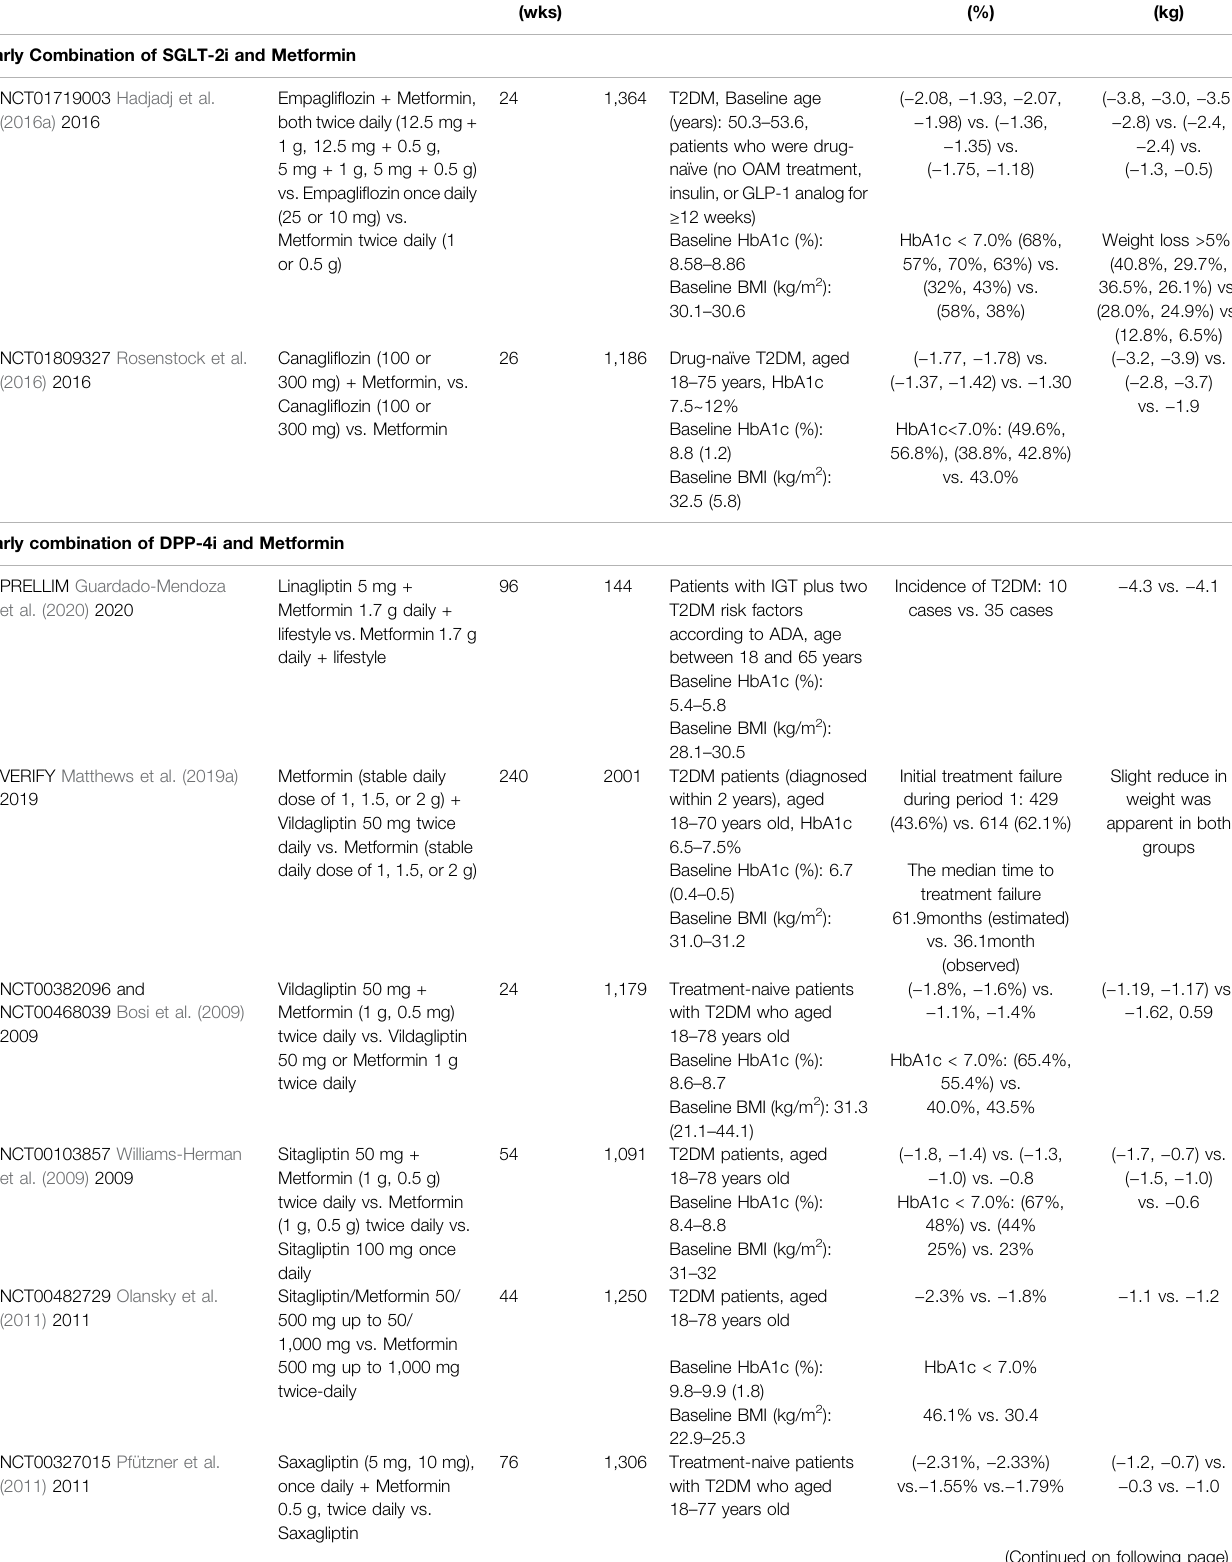
TABLE 3 | Randomized controlled trial of early combination therapy with new hypoglycemic drugs in T2DM and prediabetes.